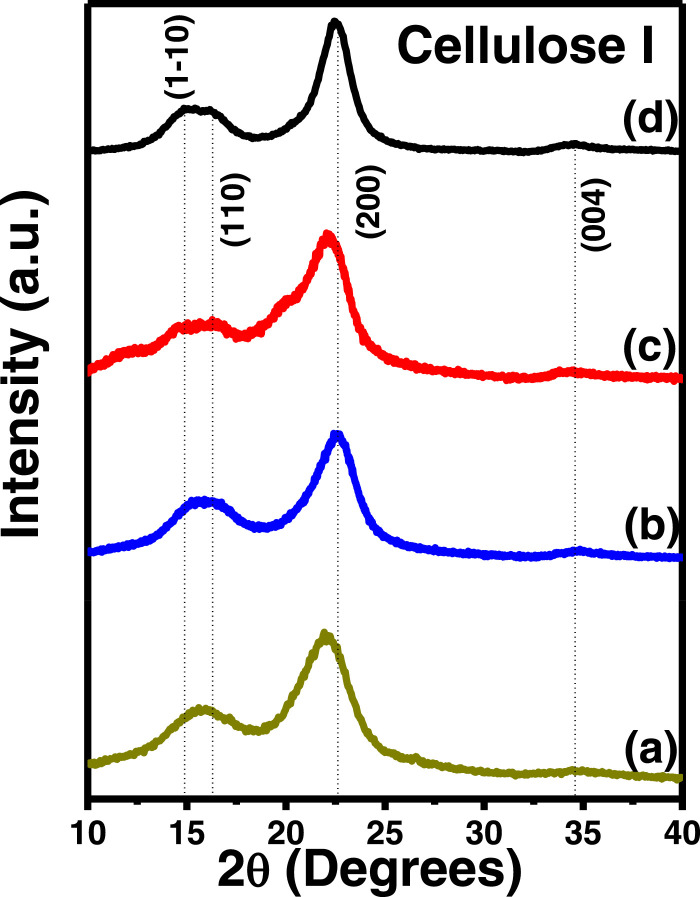
XRD patterns of (a) raw SCB, (b) SCB cellulose produced with 5 wt.% NaOH, 45 wt.% H2SO4, (c) SCB cellulose produced with 10 wt.% NaOH, 45 wt.% H2SO4 and (d) Commercial cellulose using 75°C.